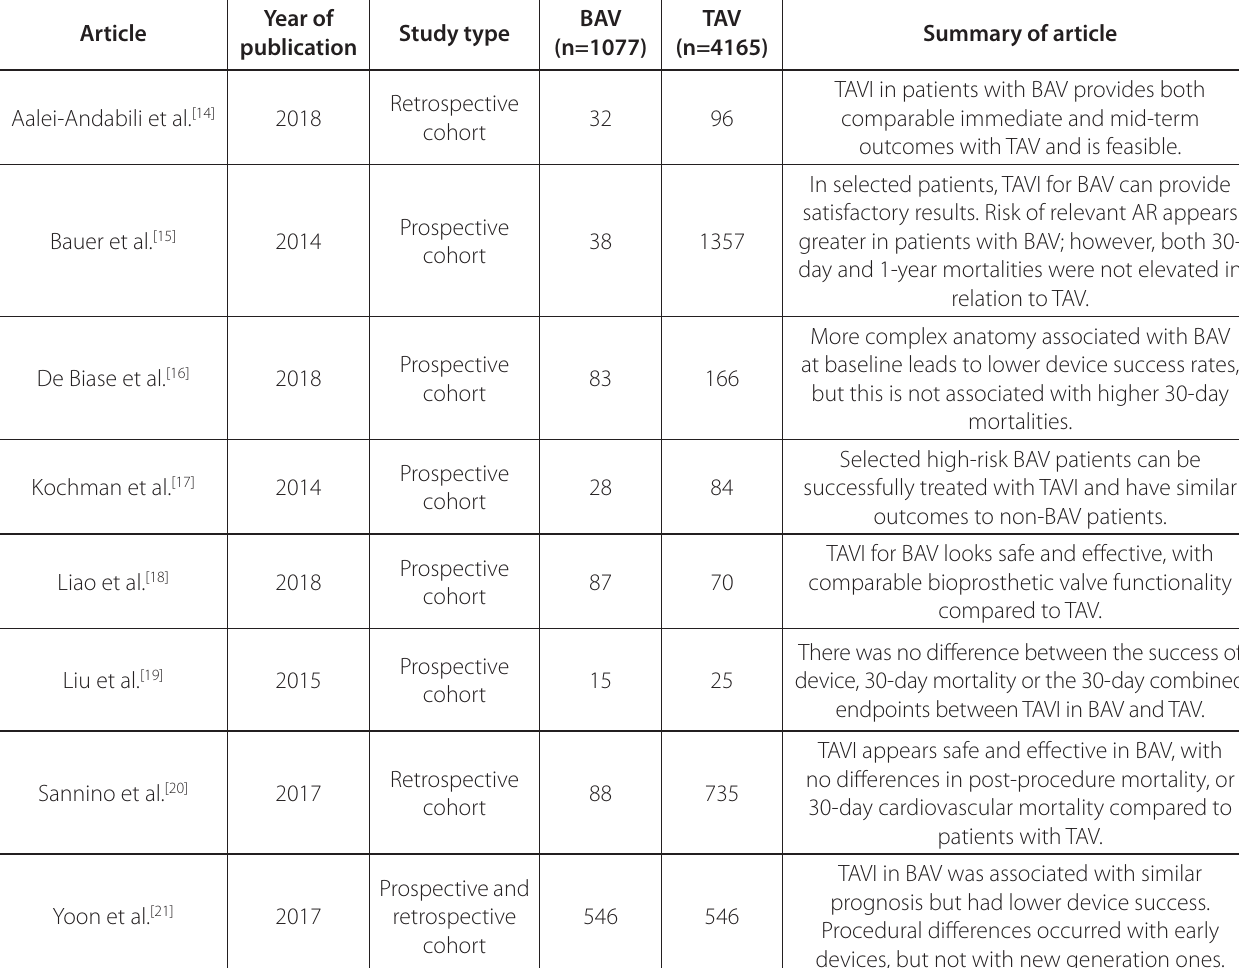
Table 1 . Summary of all included studies.